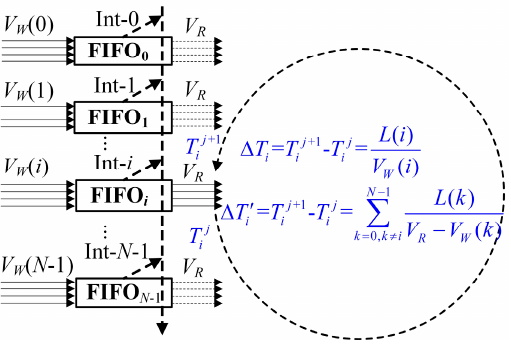
Figure 2. The time slot transition diagram of the N FIFOs reading operations. Table 2. The N -group scanning and the N -FIFO caches depth ratios.